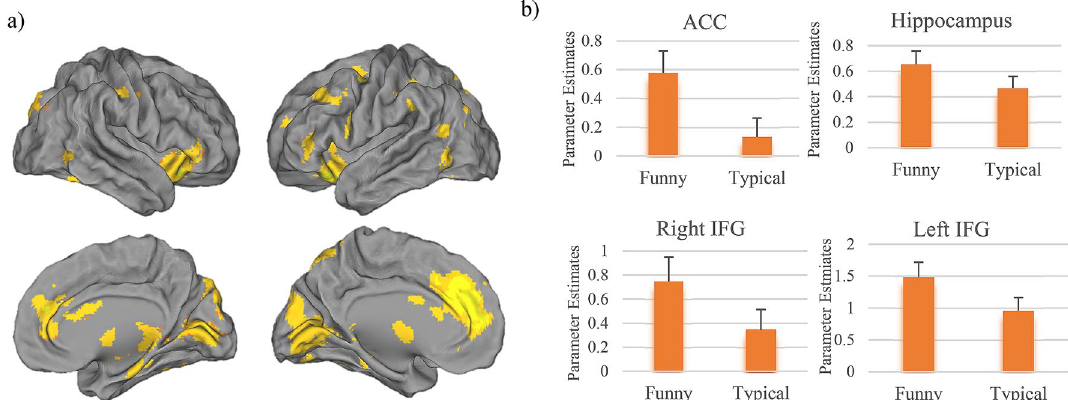
Figure 1. Functional activity analysis: ( a ) the functional activity analysis of the generating FUN > TYP ideas contrast shows activity in a set of fronto-temporal brain regions (t values are plotted), such as ( b ) presentation of the parameter estimates (mean beta values per condition) of the right ACC, the bilateral IFG and the left hippocampus. The error bars represent